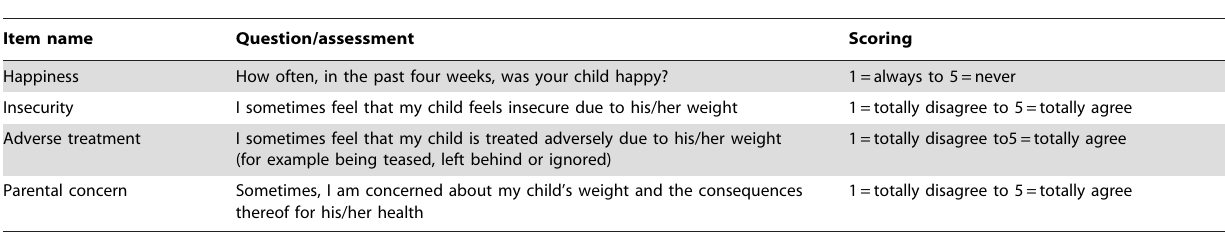
Table 1. Overview of items providing an indication of psychosocial